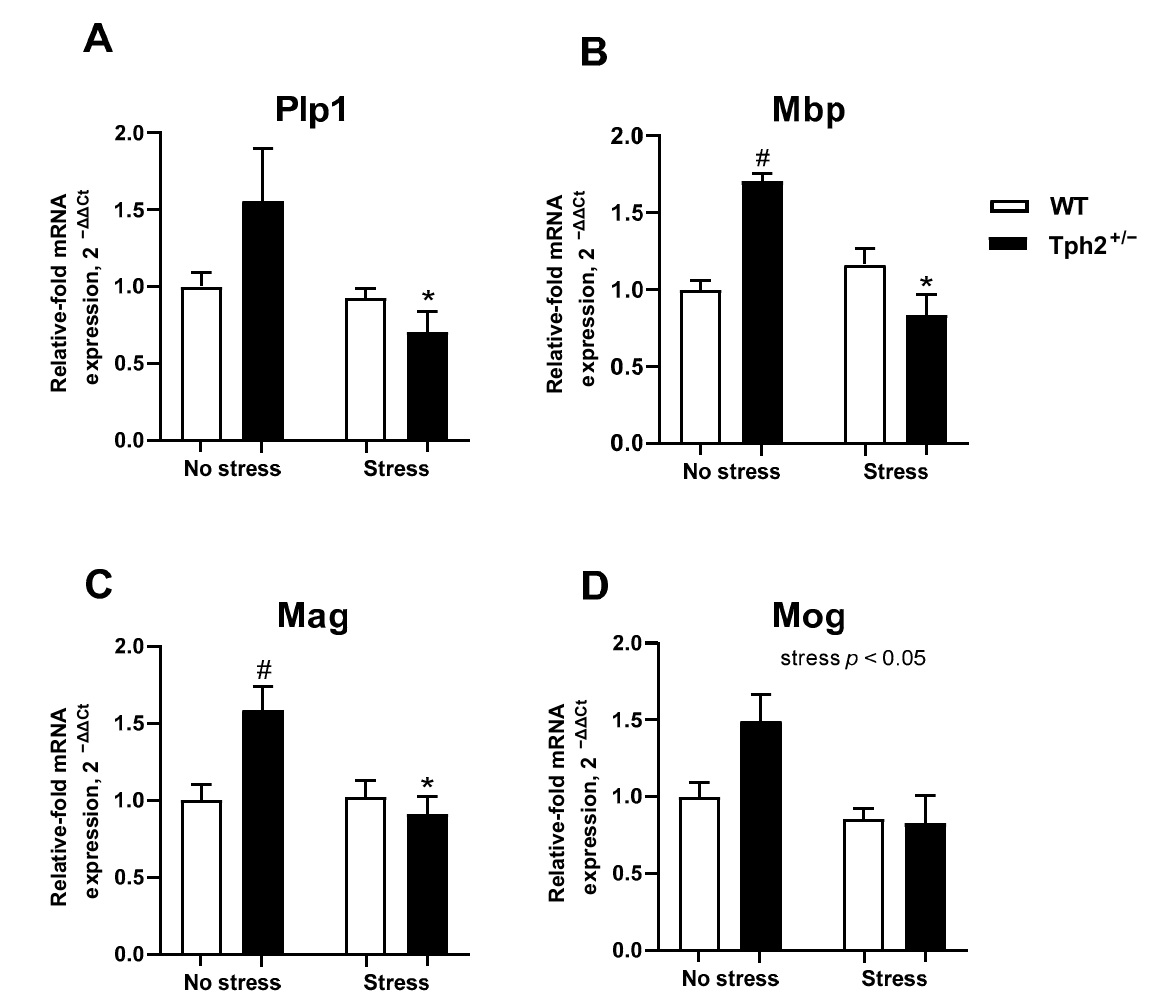
Figure 4. Elevated expression of myelination-related genes in the prefrontal cortex of non-stressed Tph2 +/ − mice. ( A ) Significantly lower expression of Plp1 was observed in stressed Tph2 +/ − mice in comparison to the non-stressed Tph2 +/ − group. WT no stress (NS) n = 5, WT stress (S) n = 9, Tph2 +/ − NS n = 5, Tph2 +/ − S n = 4. ( B , C ) Compared to non-stressed Tph2 +/ − group, expression of Mbp and Mag was significantly lower in both stressed Tph2 +/ − and non-stressed Tph2 +/+ mice. Mbp : WT NS n = 4, WT S n = 9, Tph2 +/ − NS n = 3, Tph2 +/ − S n = 4. Mag : WT NS n = 5, WT S n = 9, Tph2 +/ − NS n = 4, Tph2 +/ − S n = 4. ( D ) In comparison to non-stressed mice, stressed animals had a significantly lower expression level of Mog , irrespective of the genotype. WT NS n = 5, WT S n = 9, Tph2 +/ − NS n = 4, Tph2 +/ − S n = 5. WT—wild type, * p < 0.05 vs. same-genotype non-stressed group, # p < 0.05 vs. stress-matched WT